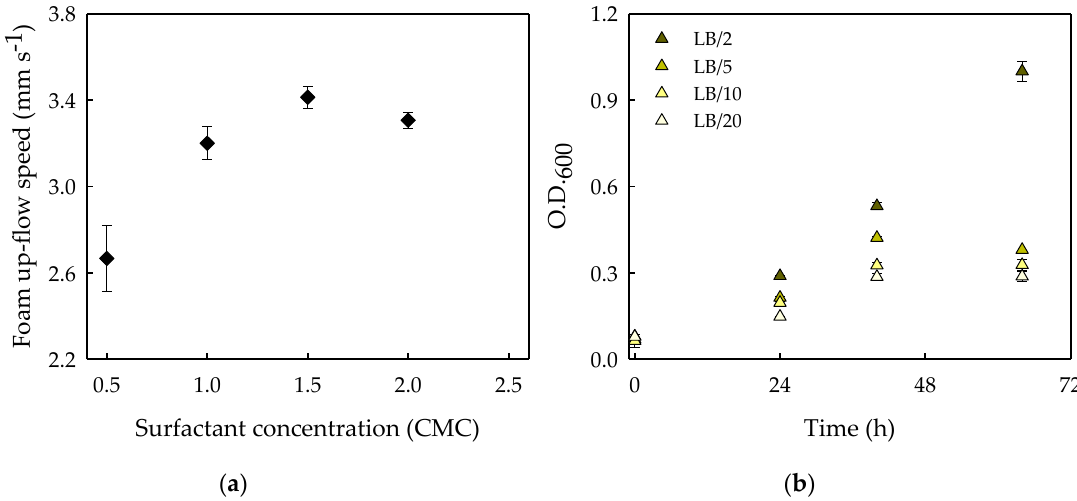
Figure 5. ( a ) Foamability of the surfactant Saponin in 100 mL of LB culture medium expressed in terms of the foam up-flow speed achieved after 30 s of foaming (mm s −1 ) as a function of the surfactant concentration (CMC). The average values of three experimental replicates are shown, together with their corresponding standard deviations. ( b ) Bacterial growth expressed as optical density at 600 nm (O.D. 600 ) in LB culture medium 2-, 5-, 10- and 20-fold diluted. The average values of duplicate cultures are shown, together with their corresponding standard deviations.